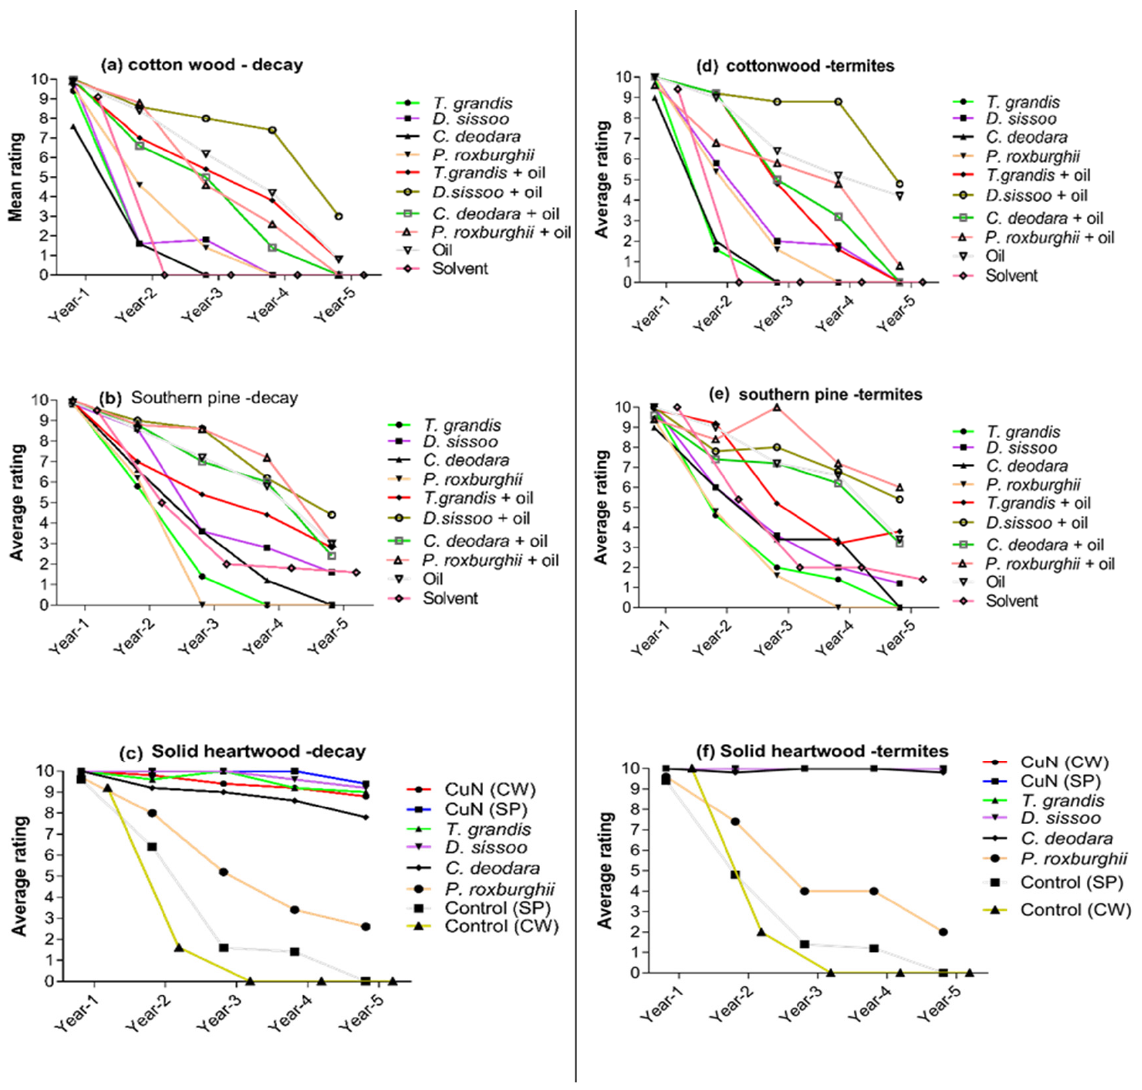
Figure 1. Average decay fungi damage rating for treated cottonwood ( a ), southern pine ( b ), untreated solid heartwood stakes ( c ), and average termite damage rating for treated cottonwood ( d ), southern pine ( e ), untreated solid heartwood stakes ( f ), exposed in the field for five years following the AWPA E7 ground contact test.